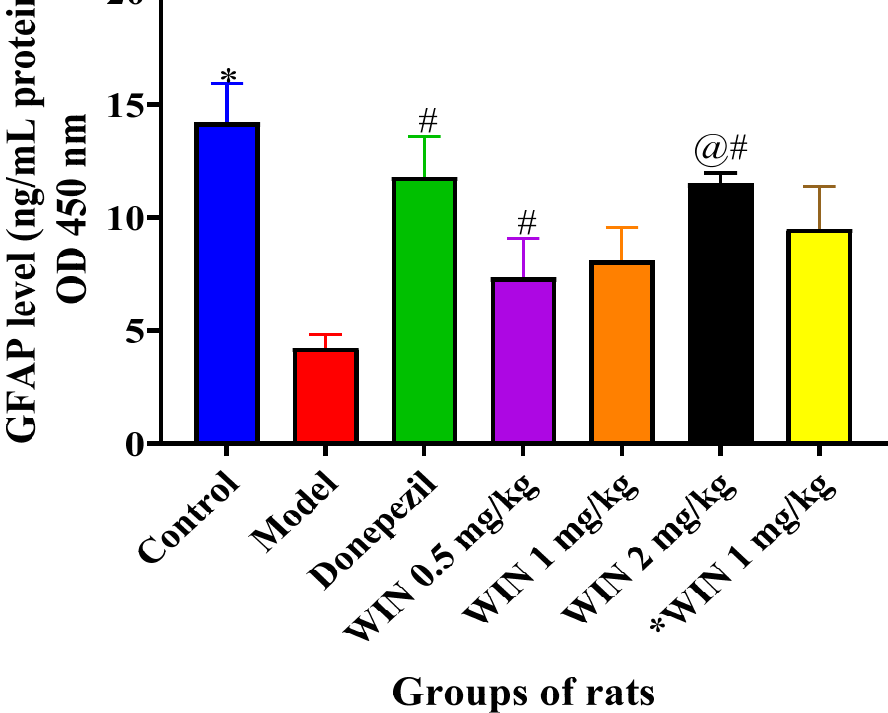
Figure 10. Effects of WIN on GFAP levels in the brain of D -gal- and AlCl 3 -induced rats. Value are reported as mean ± SEM, n = 5. * p < 0.05 vs. control group, # p < 0.05 vs. donepezil and @# p < 0.05 vs. WIN2 mg/kg group.